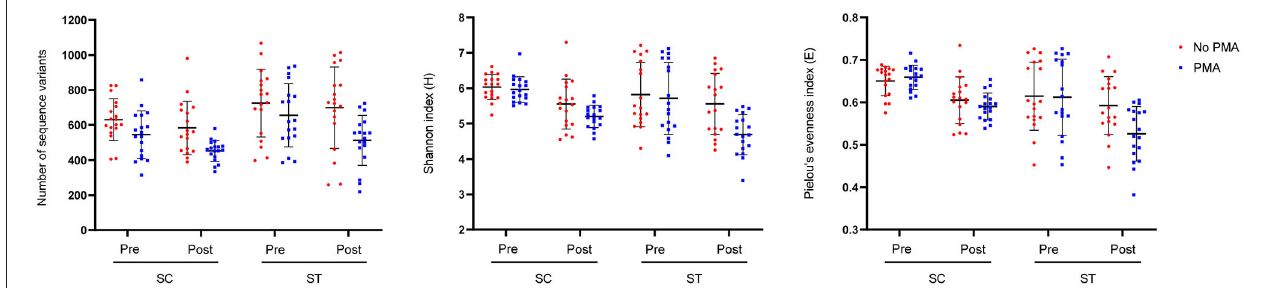
FIGURE 2 | Alpha-diversity indices (number of sequence variants, Shannon index and Pielou’s evenness index) measuring the richness, diversity, and evenness of total (No PMA) and viable (PMA) bacterial communities before and after chlorine disinfection. The samples collected bimonthly over a year were represented by individual data points with error bars (mean ± 1S.D). All samples were rarefied to the minimum depth of filtered reads and the sequence variants were used for calculation.